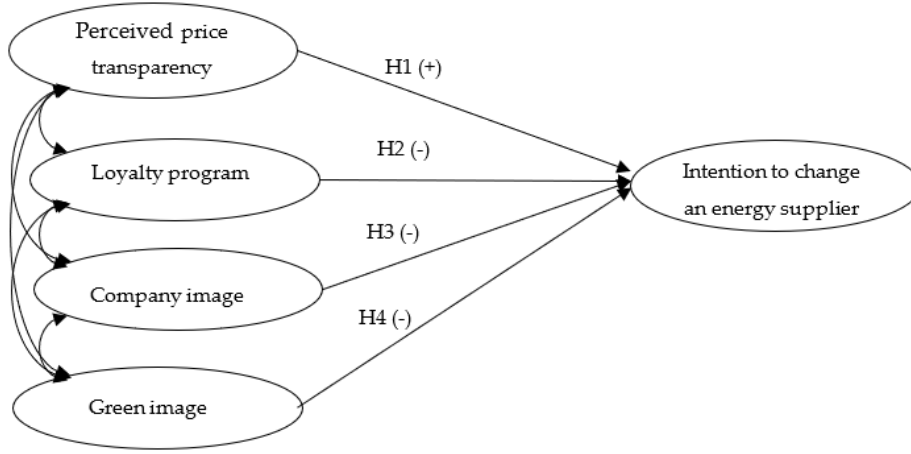
Figure 1. Conceptual research model. Note: (+) positive impact, (-) negative impact.